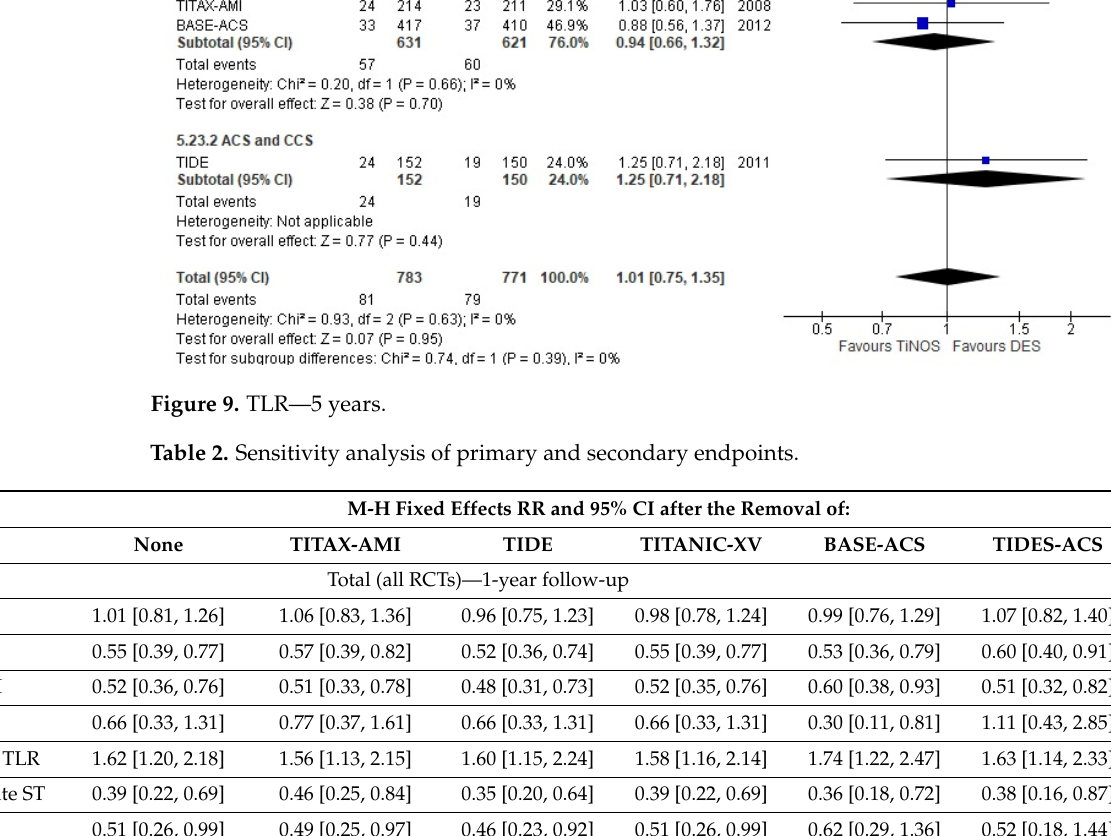
Table 2. Sensitivity analysis of primary and secondary endpoints.